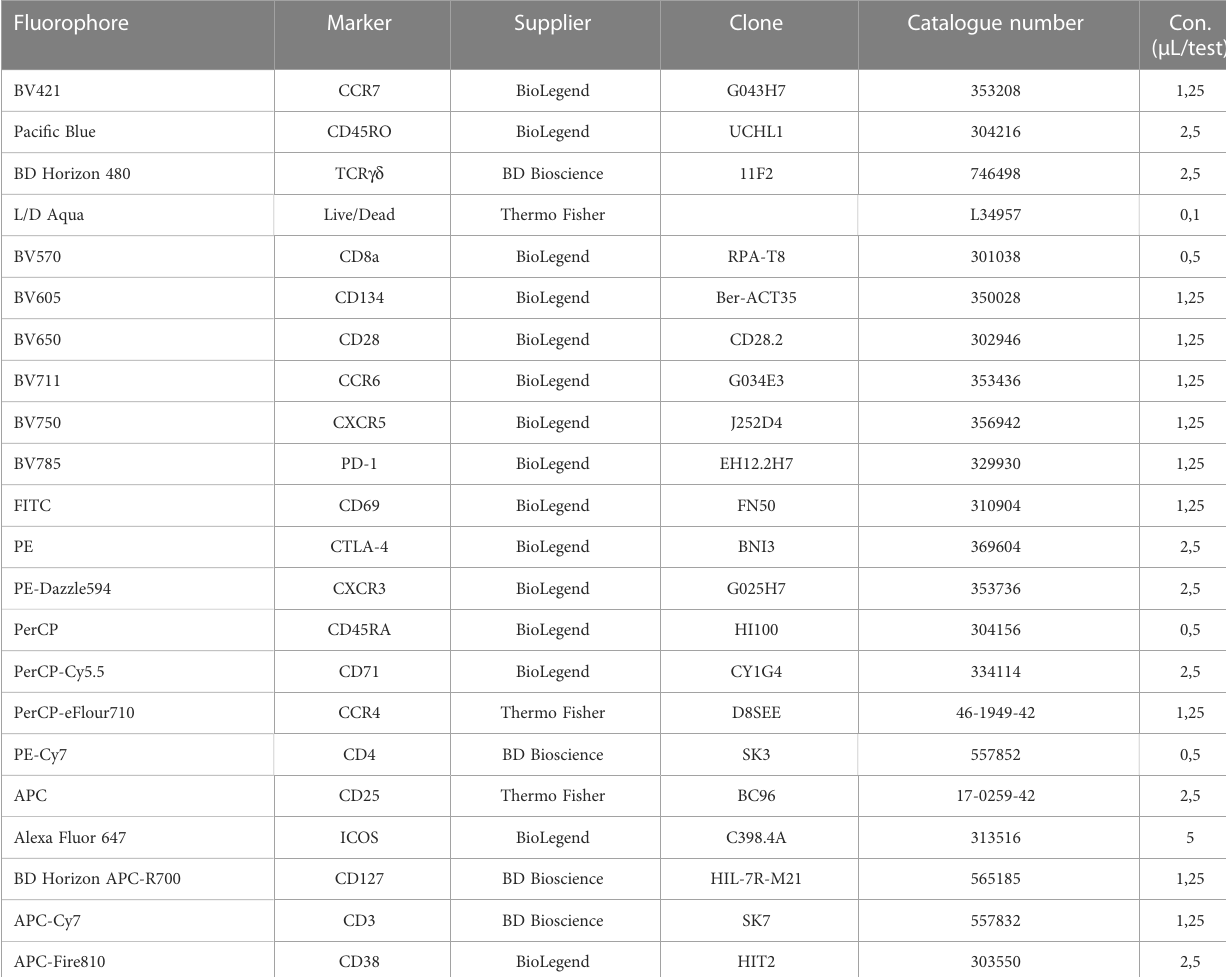
TABLE 4 Reagents and dilutions used for the T cell panel.